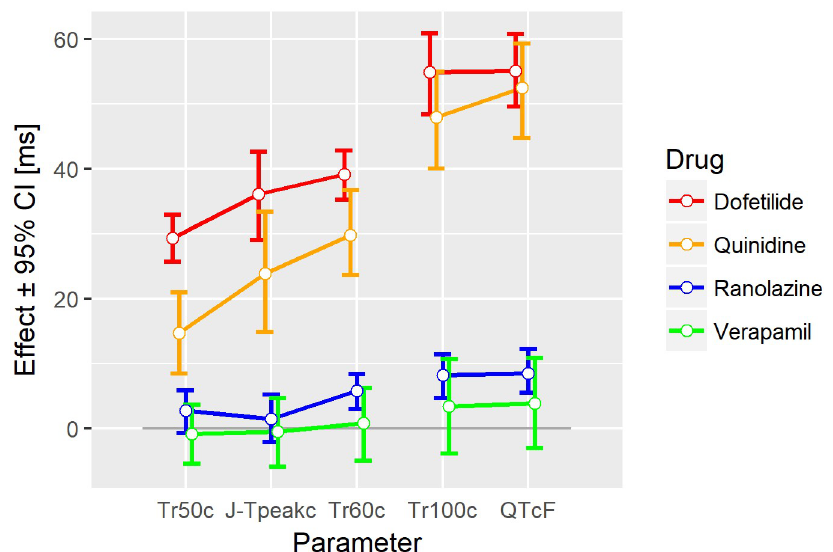
Fig 6. Drug effects on selected parameters in Study A. The drug effects on J-T peak c are about between the effects of the 50% and 60% T vector trajectory quantiles (Tr50c and Tr60c) but have larger confidence intervals. The effects on the 100% T vector trajectory quantile (Tr100c) are comparable to the effects on